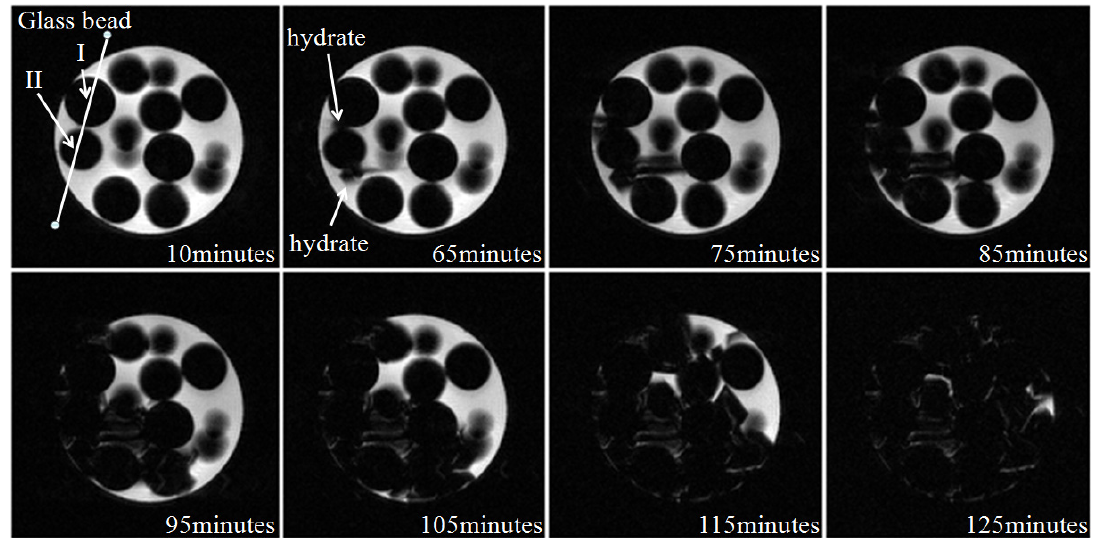
Figure 4. The images of the THF hydrate growth in one of the cross sections with